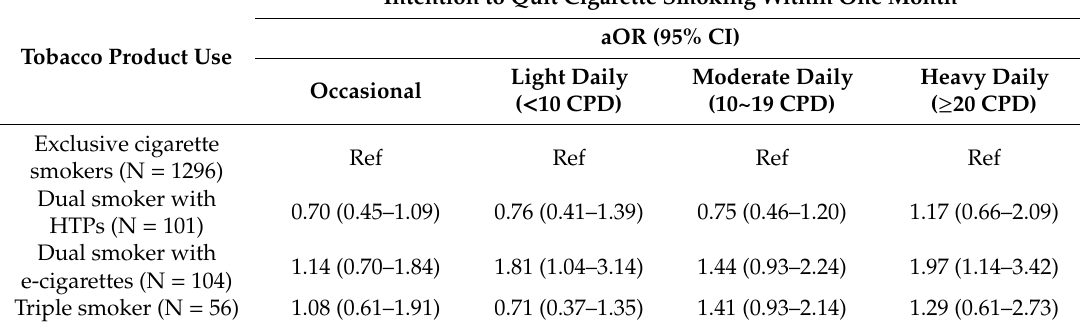
Table 3. Association between tobacco product use and intention to quit cigarette smoking within one month in terms of cigarette-smoking